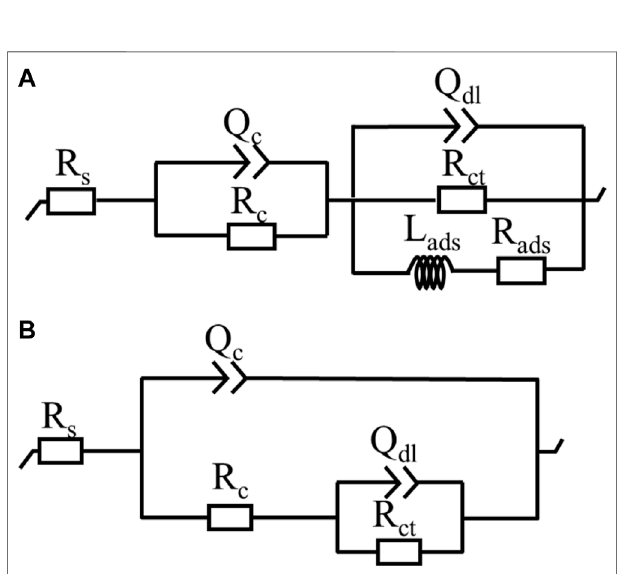
FIGURE 8 | Equivalent circuits for EIS plots: (A) bare AZ91D, (B) coated samples.